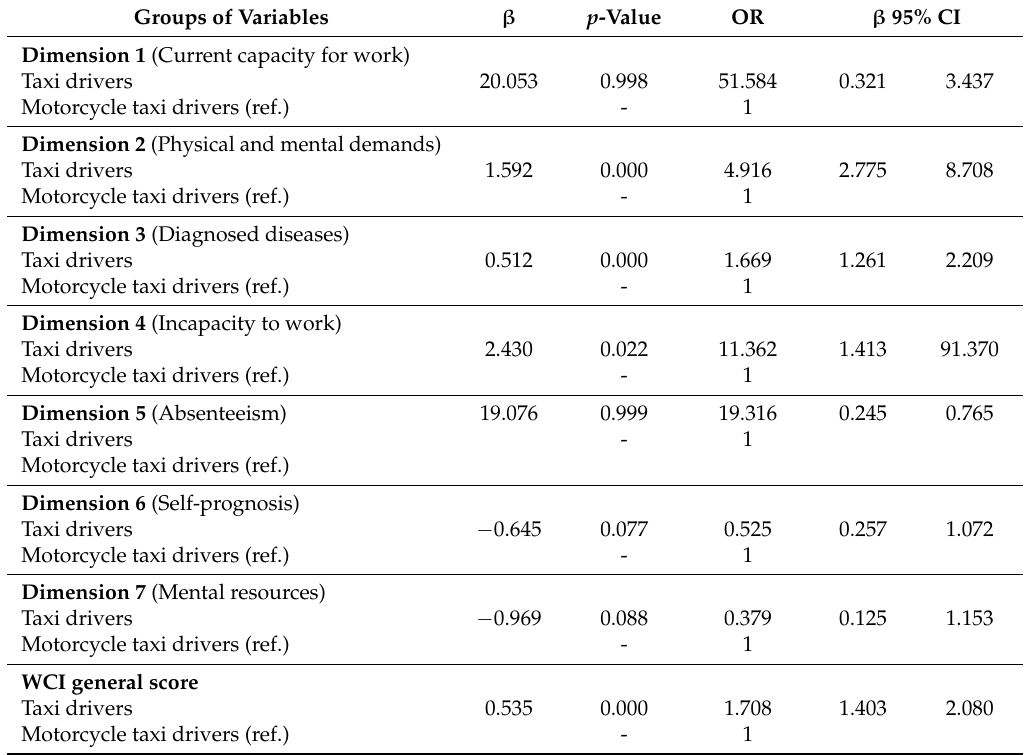
Table 5. Binary logistic regression analysis for the WCI domains according to